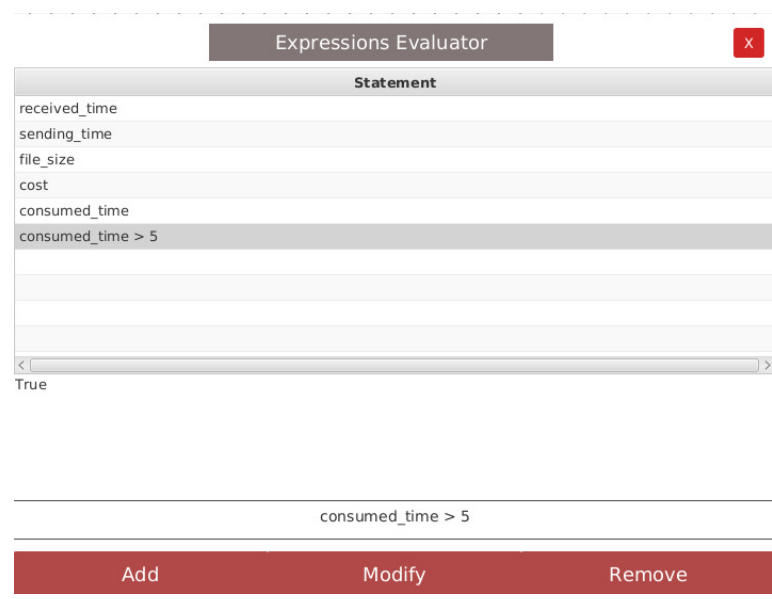
Figure 15. The expression evaluator -case study-.